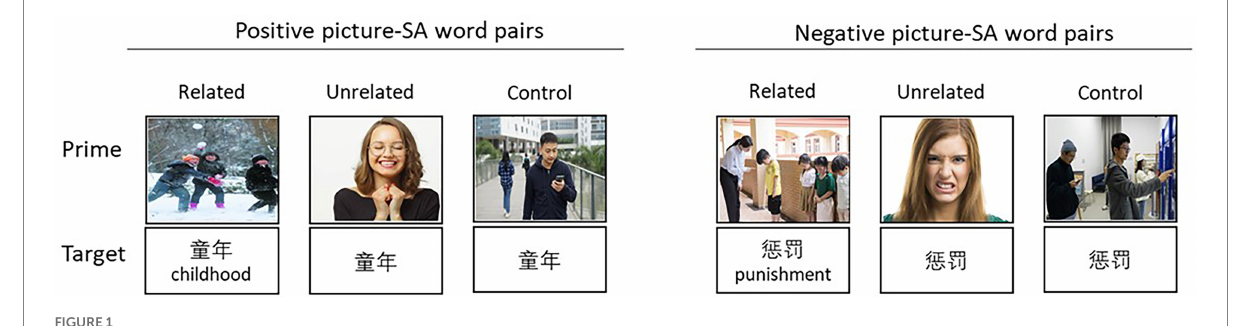
FIGURE 1 Examples of a social scene picture (left) and an emotional expression picture